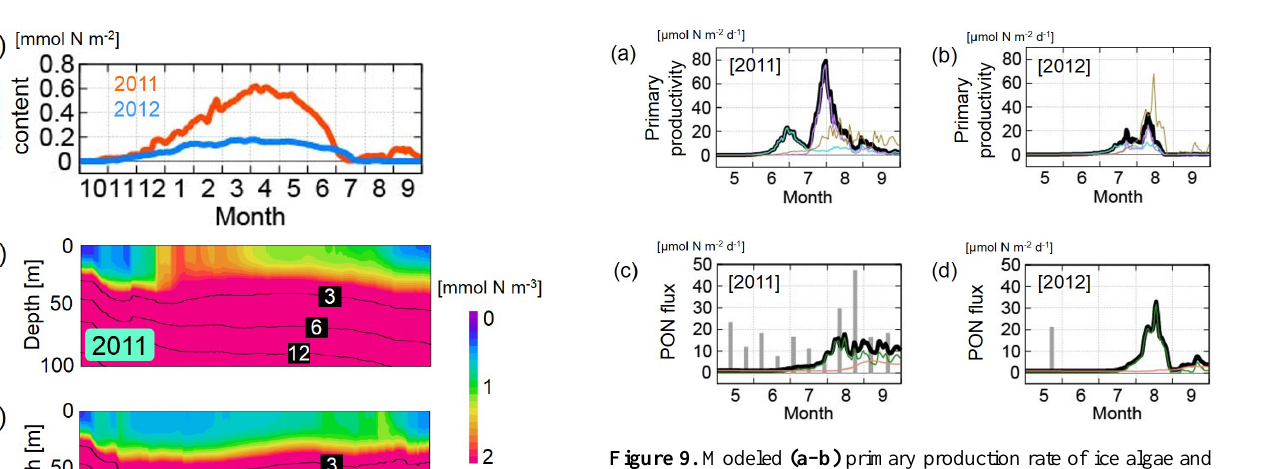
Figure 9. Modeled (a–b) primary production rate of ice algae and (c–d) PON flux in the NAP region in the (a, c) 2011 and (b, d) 2012 cases (µmolNm − 2 d − 1 ) . In (a–b) , the daily rate of total primary production (black lines) and those derived from nutrients in the skeletal layer (light blue lines) and water column (purple lines) are shown. The export flux of PON from the sea ice bottom to the un- derlying water column is overlaid by olive lines. In (c–d) , the to- tal simulated (black lines) and observed (gray bars) PON fluxes at 180m are compared. The fluxes originating from ice algae (green lines) and pelagic plankton groups (orange lines) are also